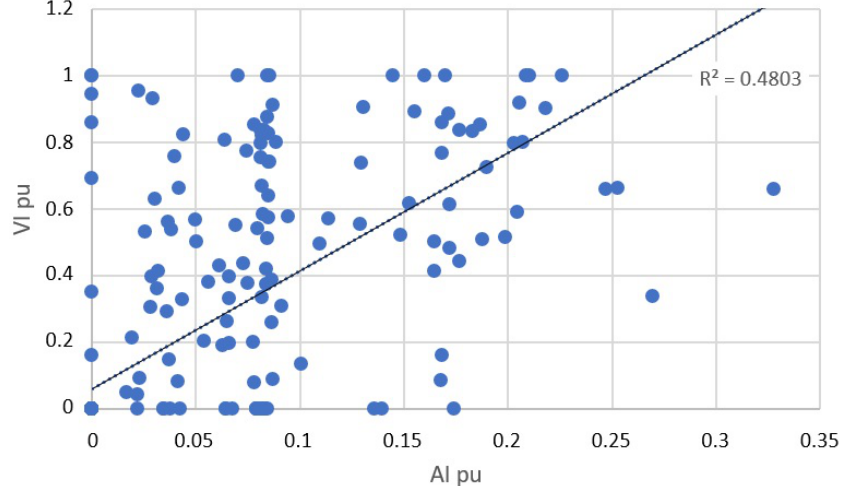
Figure 5. Chart with correlation (R 2 = 0.48) per plot between Accessibility Index to (semi-)public spaces (AI pu ) on the x-axis and Visibility Index to (semi-)public spaces (VI pu ) on the y-axis. Differently, the Accessibility Index to private space (AI pri ) and the Visibility Index to private space (VI pri ) are not correlated (R 2 = 0.0046), which means that the higher accessibility to private spaces is not necessarily accompanied by higher visibility (see Figure 6).